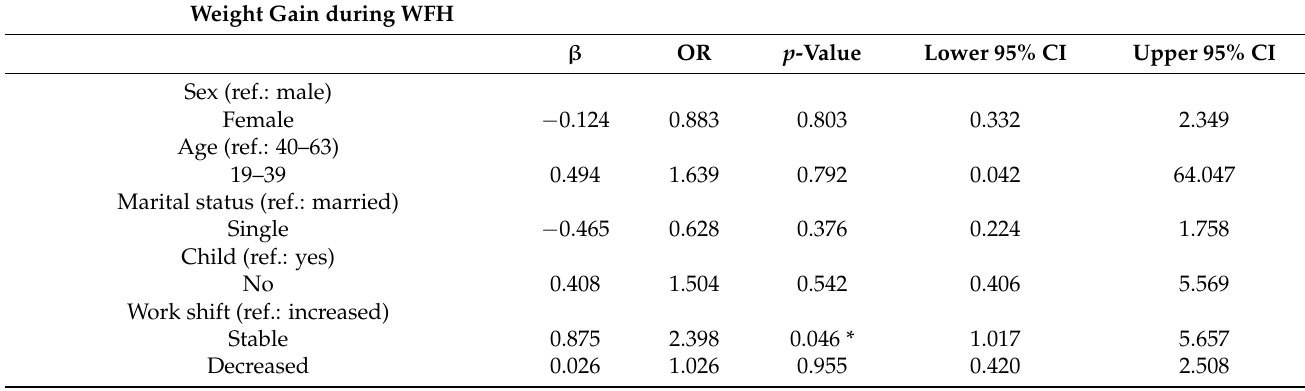
Multinomial logistic regression model of changes in body weight and